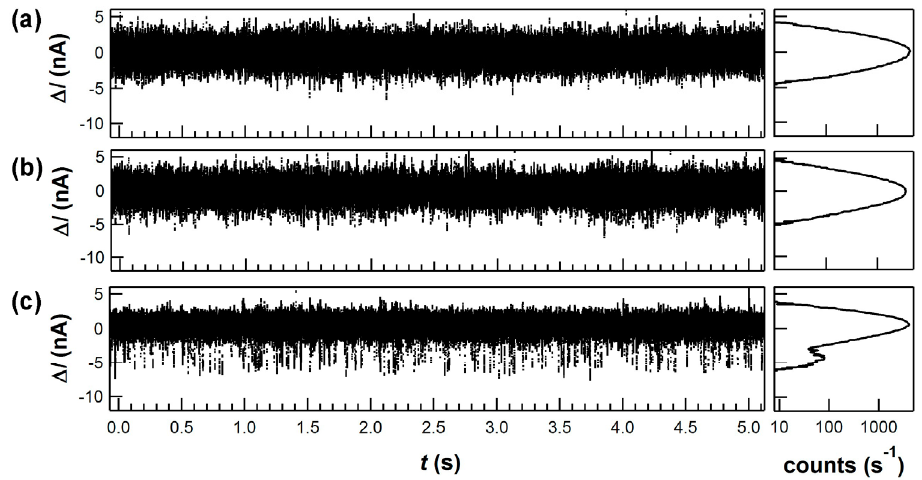
Figure 2. Example ∆ I ( t ) signals and signal histograms generated by KF in a solution containing: ( a ) 1 nM poly(dA) 42 homopolymer template; ( b ) template with 10 μ M non-complementary dGTP; and ( c ) template with 10 μ M complementary dTTP. Both ( a ) and ( b ) are indistinguishable from the baseline noise fluctuations observed from a SWNT, either with or without KF attachments. Only combinations of a successful KF attachment and a solution containing template and complementary dNTPs produced the type of additional excursions shown here.